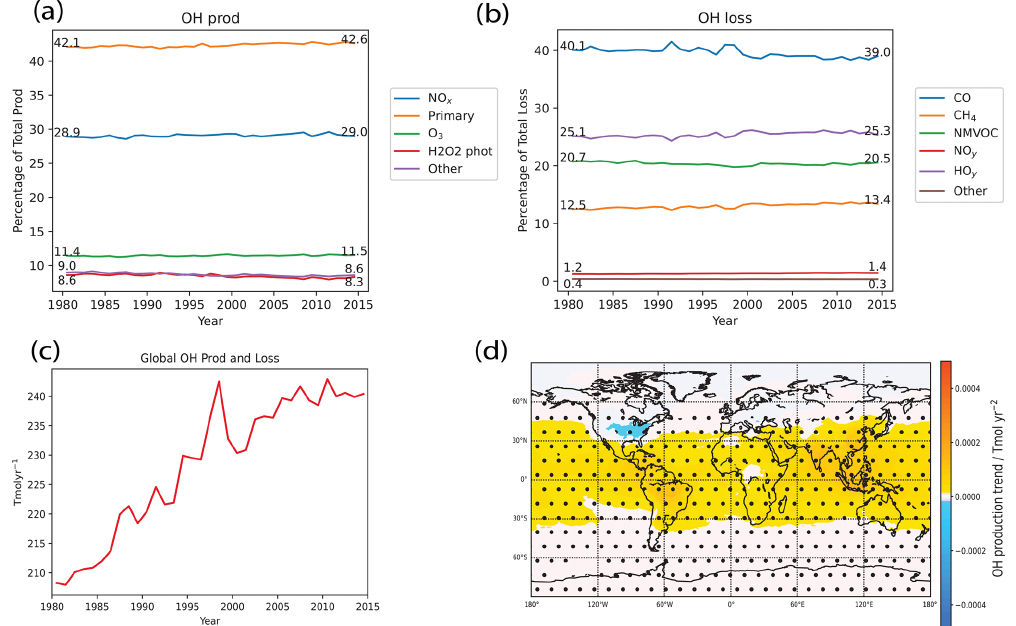
Figure 6. Tropospheric air-mass-weighted OH chemical production and loss terms in the Base run. (a) Evolution of the proportion of each production reaction with respect to the total and (b) the same but for loss reactions instead. (c) Time evolution of global total production and loss terms (curves overlap because OH is in pseudo steady state). (d) Spatial air-mass-weighted tropospheric OH chemical production trend over the 1980–2014 period, with stippling and trends as per Fig. 3. From panels (a) and (b) , we see that the relative proportions stay roughly constant throughout the time period, suggesting that all of the reaction terms have increased in tandem with the total, and the values are roughly consistent with Table 1 of Lelieveld et al. (2016). From panel (c) , both global tropospheric air-mass-weighted OH production and loss have increased by about 14% by 2014 compared to 1980, showing a clear trend. We also see some IAV throughout the period, with year-on-year changes of up to 2%. Relating these results to the earlier findings, where we saw an increasing [OH] trend, the increasing trend in both production and loss (as they balance each other in steady state) should therefore be driven by an increasing trend in production, and that in turn should be associated with the net NO x and CH 4 effects. Meanwhile, the IAV observed in the OH concentrations should also be associated with the IAV seen in the production and loss, and this in turn should be affected by meteorological factors, factors that are driven by meteorology like lightning NO x and biogenic VOC emissions and CO emissions. From panel (d) , we see that spatial chemical production trends matches the spatial [OH] trend plot for the Base run in Fig. 3, suggesting again the role of chemical production (and loss) in driving [OH]